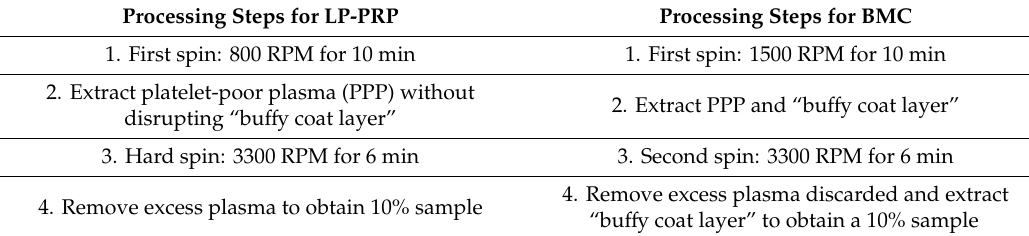
Table 5. Manual extraction and centrifugation steps used to prepare leukocyte-poor